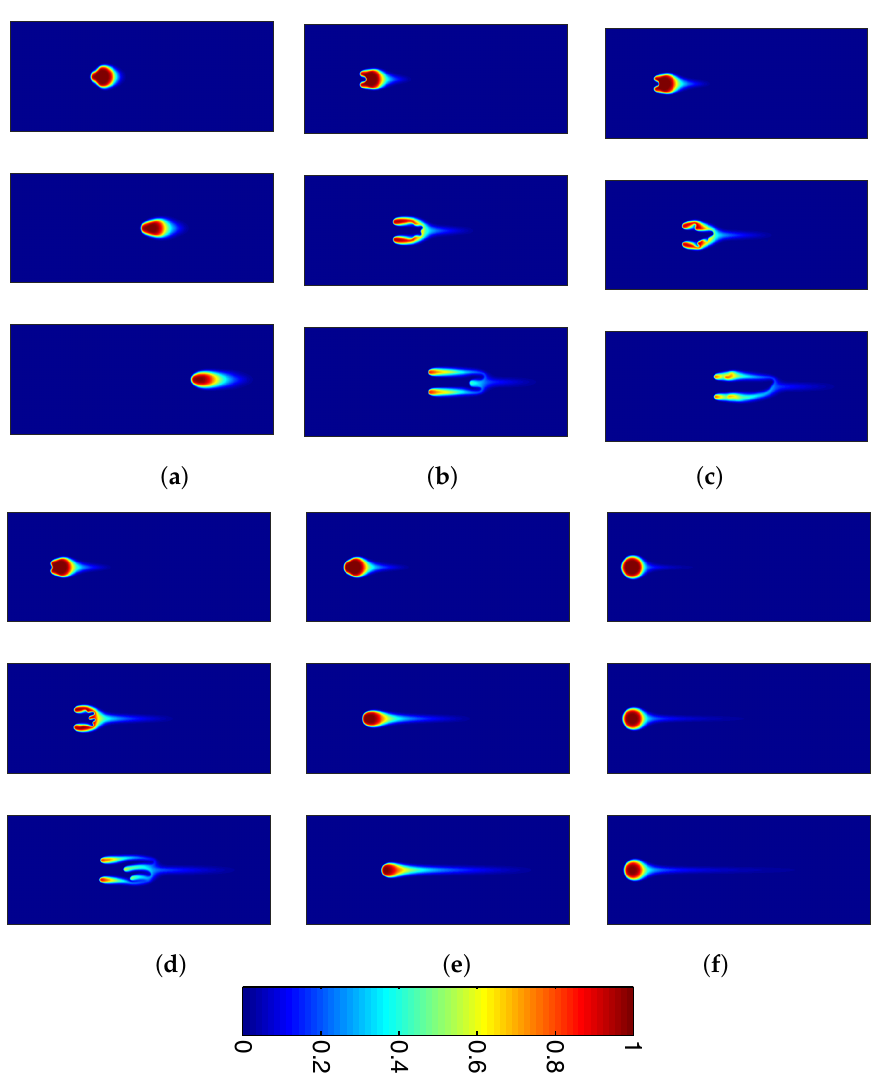
Figure 2. Spatial distribution of concentration at t = 40, 70, 100 seconds from top to bottom (in each subfigure), for Pe = 1000 and ( a ) R = 0.5, ( b ) R = 1.25, ( c ) R = 1.5; ( d ) R = 1.75; ( e ) R = 2; ( f ) R =